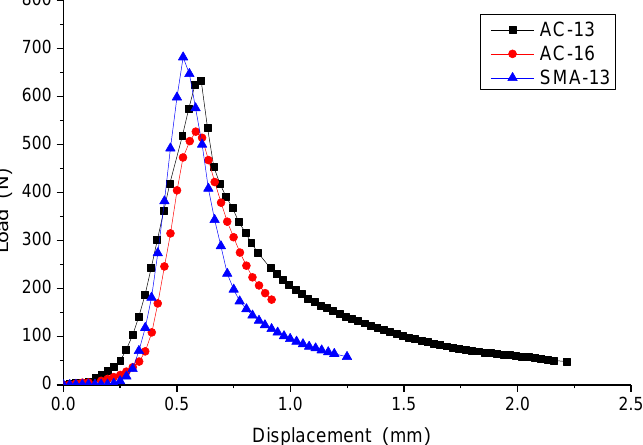
Figure 7. Load-displacement diagram of asphalt mixture beams with a notch depth of 12 mm